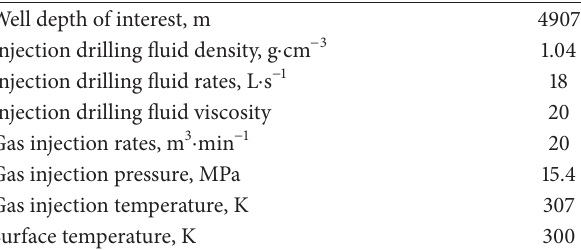
Figure 16: Simulated and actual gas outlet rates when the high permeable zone at the depth of 4907 m was penetrated. Table 2: Some required parameters used in the wellbore flow